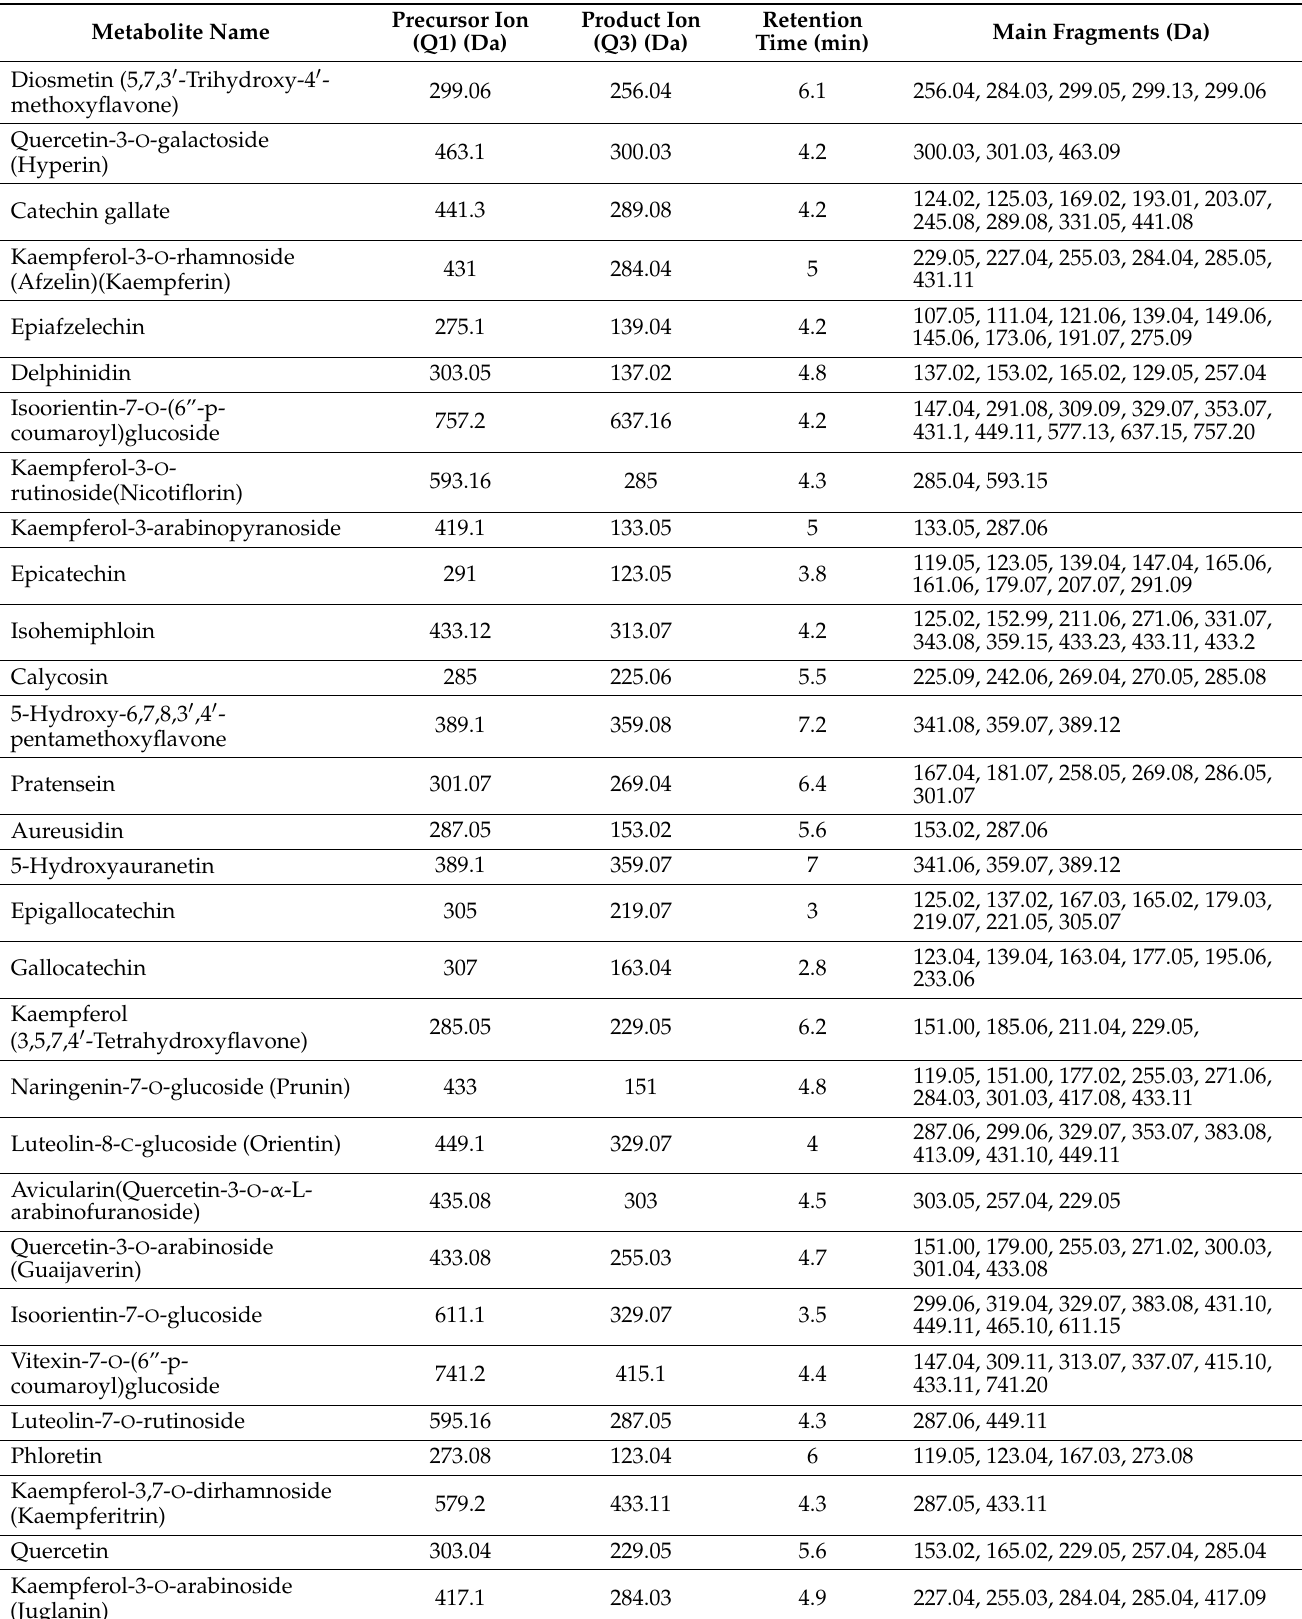
Table 1. A list of 30 flavonoids tentatively identified in C. rotundifolia